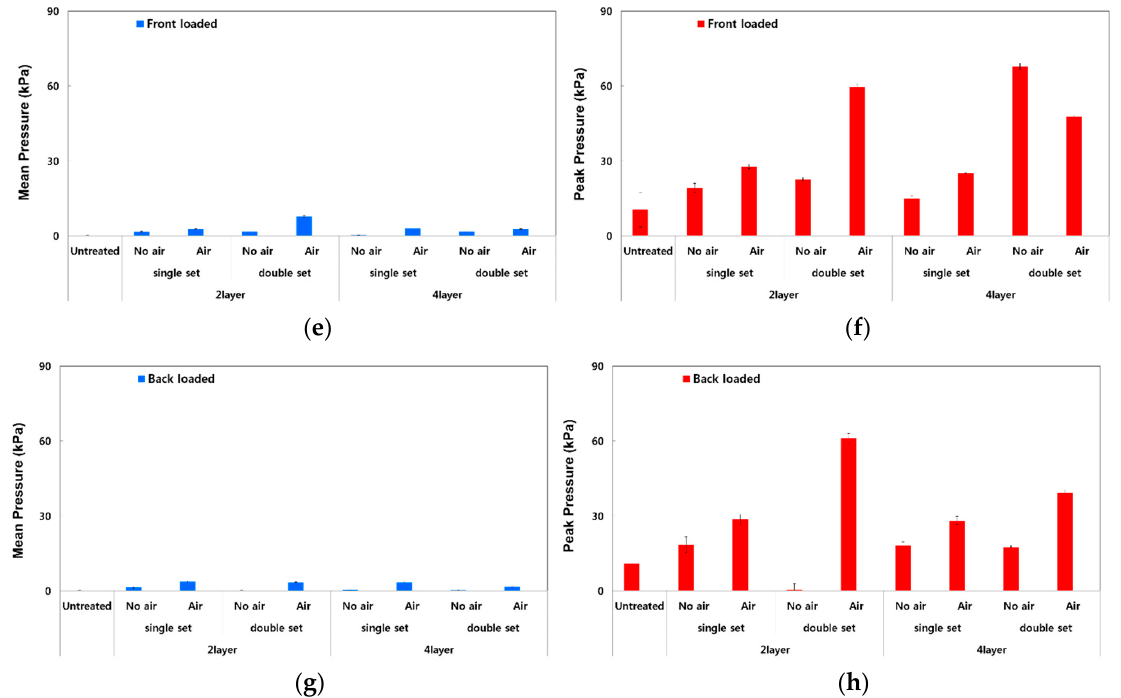
Figure 9. Mean pressure and peak pressure on the waist during standing (( a ) and ( b )), loaded (( c ) and ( d )), front-loaded (( e ) and ( f )), and back-loaded (( g ) and ( h )) postures.